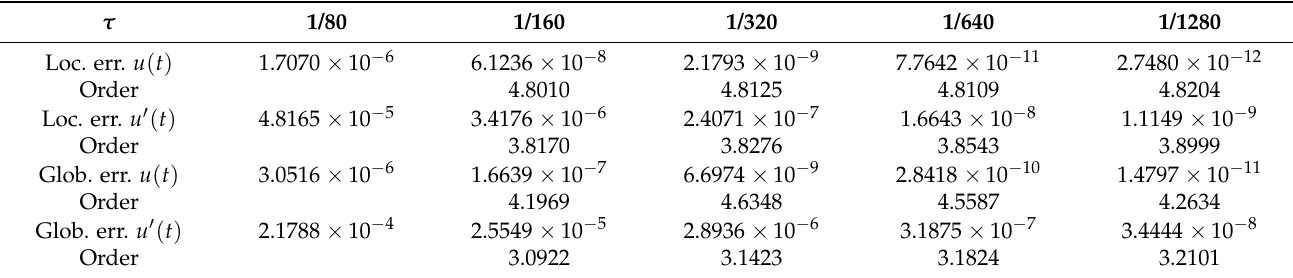
Table 9. Local and global errors and orders for problem (3) with RN4.